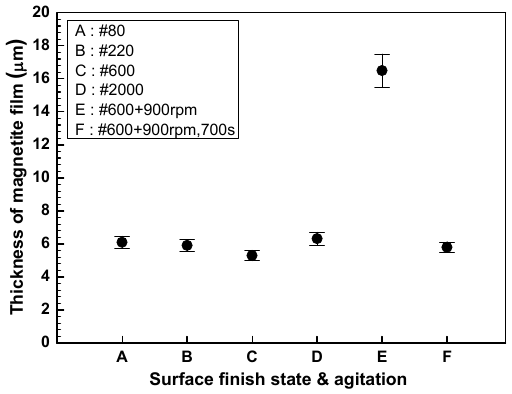
Figure 7. Thickness of the magnetite films on carbon steel substrates with different roughnesses and agitation speeds at − 1.05 V SCE in Fe(III)–TEA solution at 80 °C.